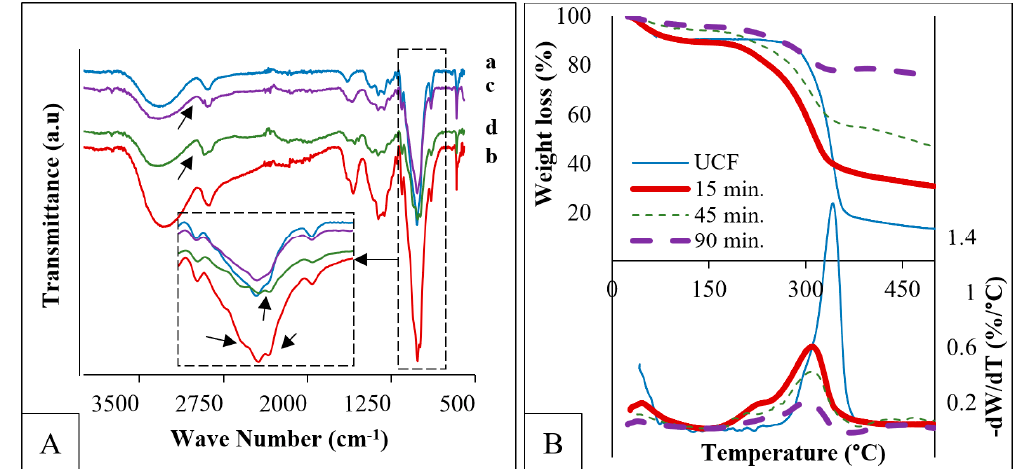
Figure 4. ( A ) Fourier-transform infrared (FTIR) analysis: a, b, c, d spectra correspond to uncoated and coated fibers for 15 min, 45 min, and 90 min respectively; ( B ) Thermo-gravimetric analysis (TGA) analysis (top) and derivative of thermo-gravimetric curves (bottom).